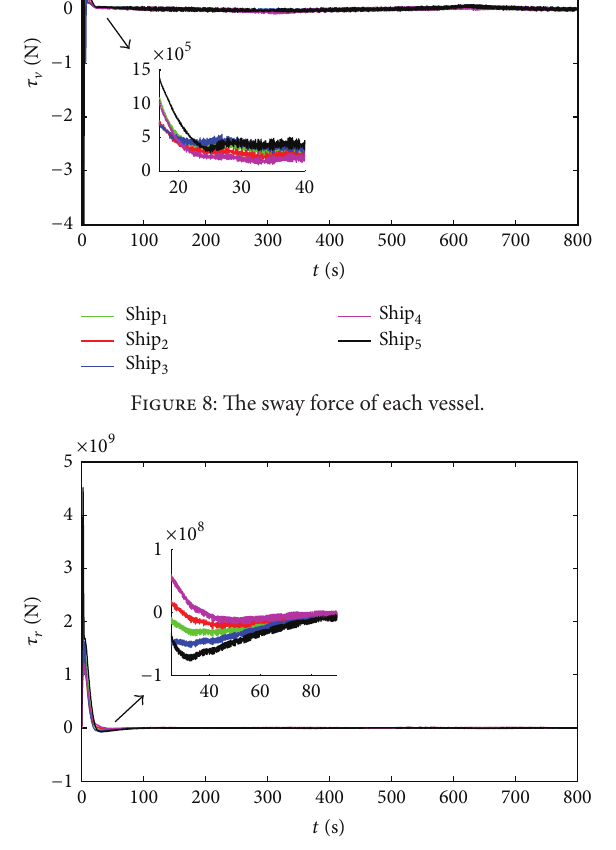
Figure 7: The surge force of each vessel.